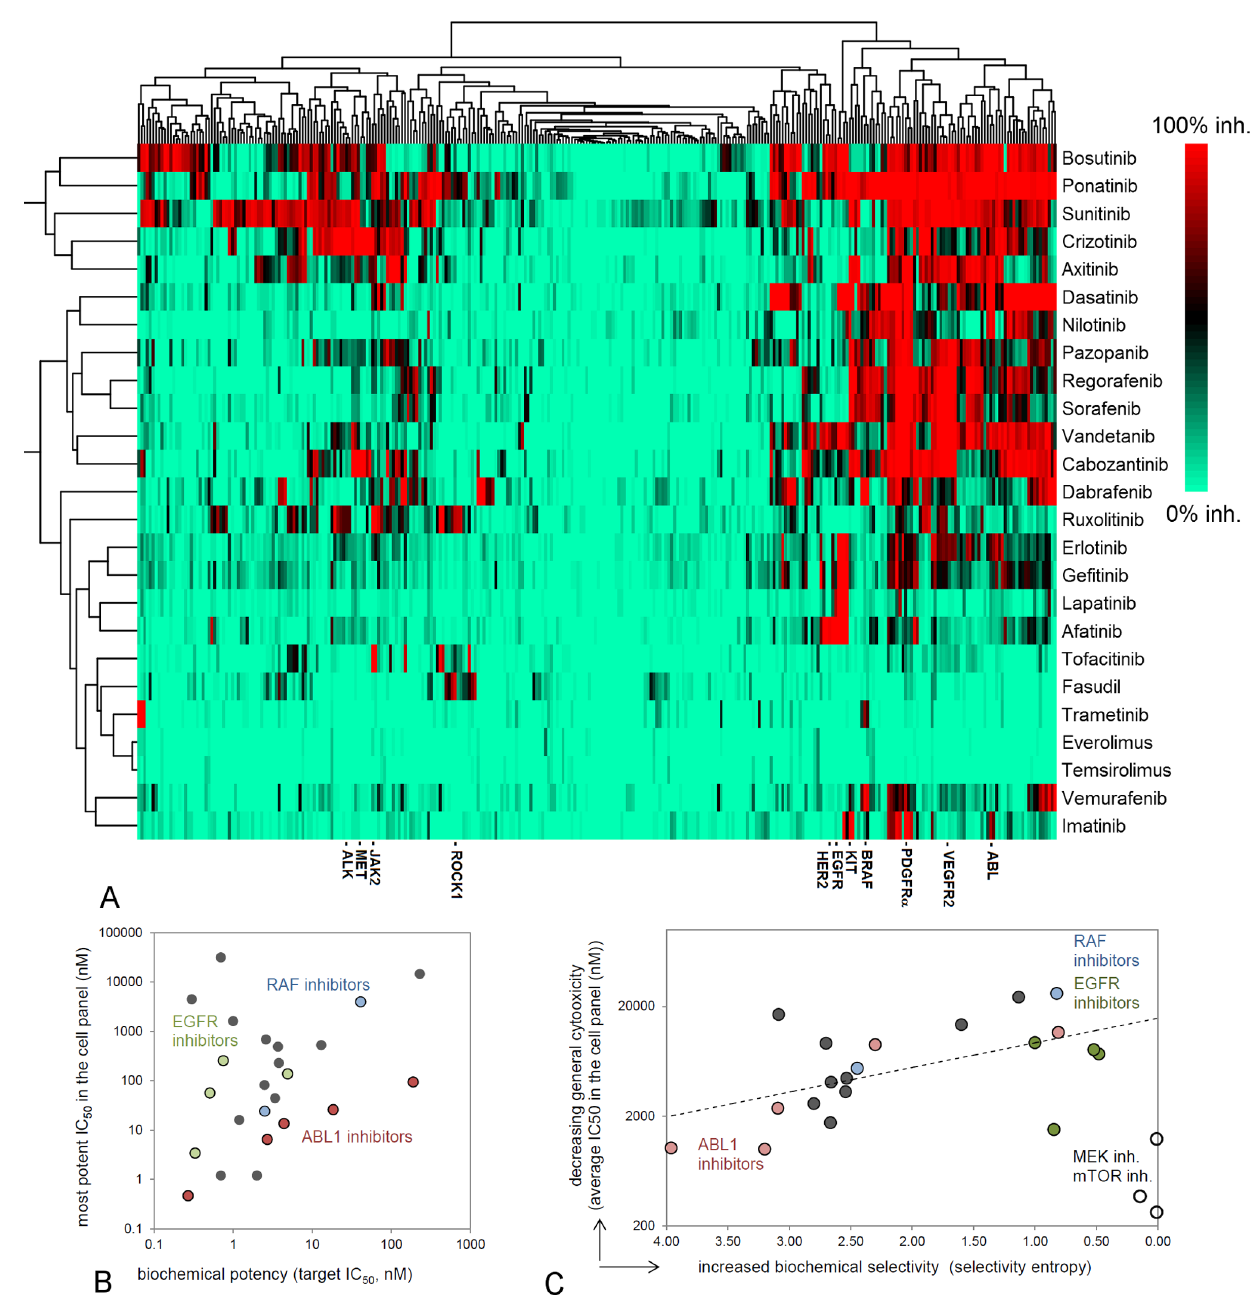
Figure 3. Biochemical profiling of marketed kinase inhibitors. A: Hierarchical clustering of inhibitory profiles of all kinase drugs in a panel of more than 300 biochemical kinase assays (%-inhibition at 1 m M inhibitor concentration). Trametinib, everolimus and temsirolimus show only minor inhibition, as mTOR and MEK kinase assays are not included in the panel. B: Potent biochemical IC 50 s on the biological target correlate with more potent cellular IC 50 s. C: Biochemical selectivity leads to a more selective response in the cell panel. Biochemical selectivity was quantified by selectivity entropy [33] and the selectivity of targeting cell growth was expressed by the average IC 50 in the cell panel. Non-oncology drugs fasudil and tofacitinib were deleted from the analysis because of lack of response. Open circles: the mTOR and MEK inhibitors everolimus, temsirolimus and trametinib,